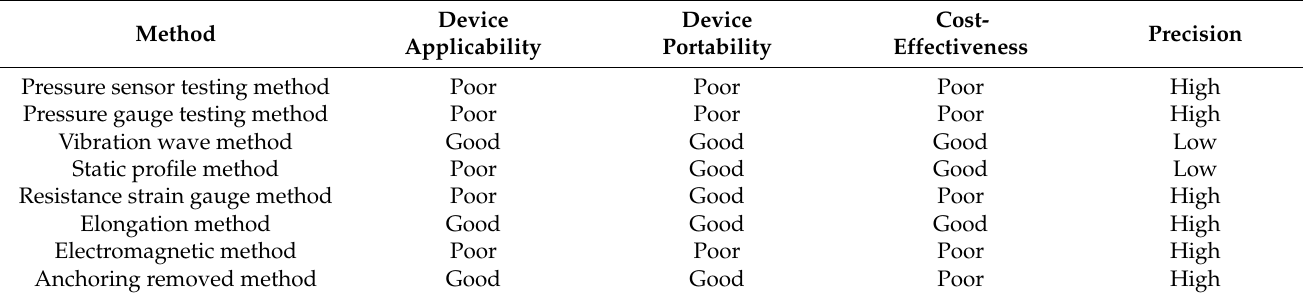
Table 1. Assessments of eight existing cable tension measuring